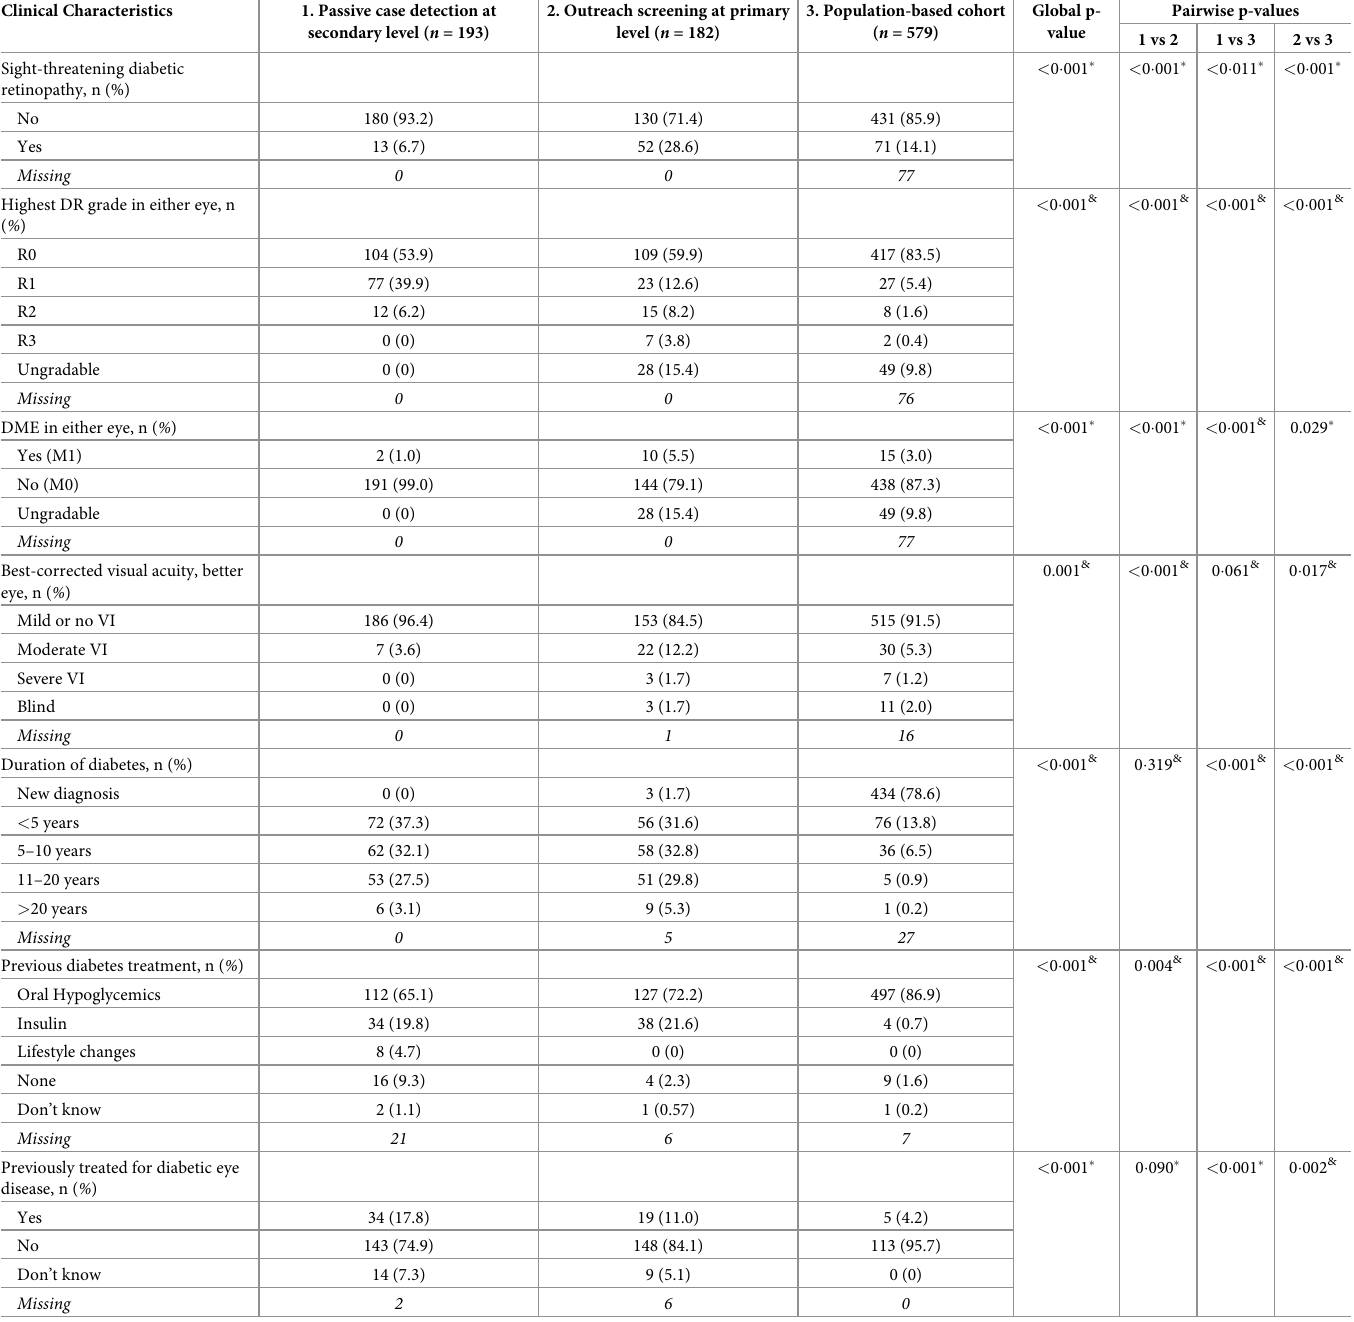
Table 2. Clinical characteristics of participants in each setting. Clinical